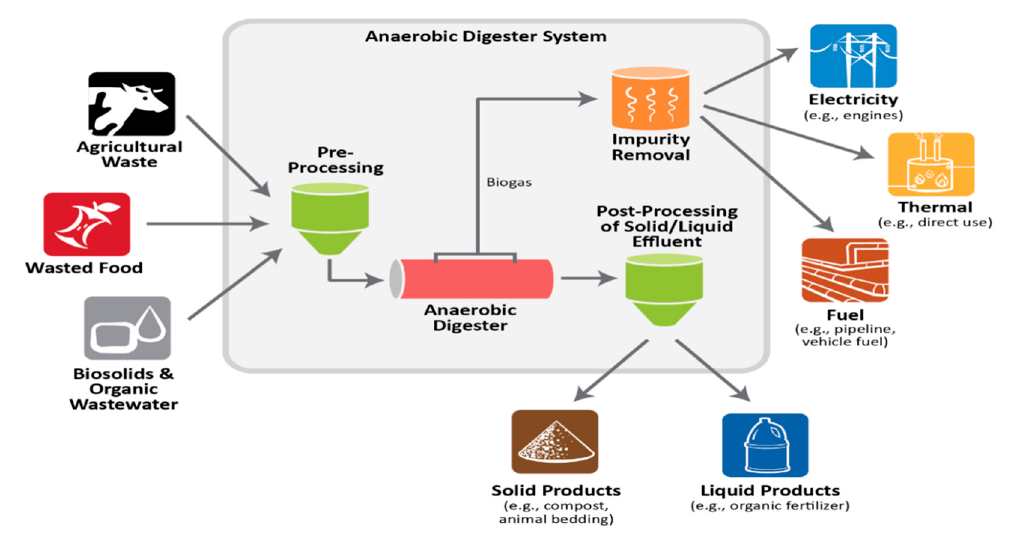
Figure 1. Anaerobic digester system [8]. Reproduced from [8], United States Environmental Protection Agency: 2015.